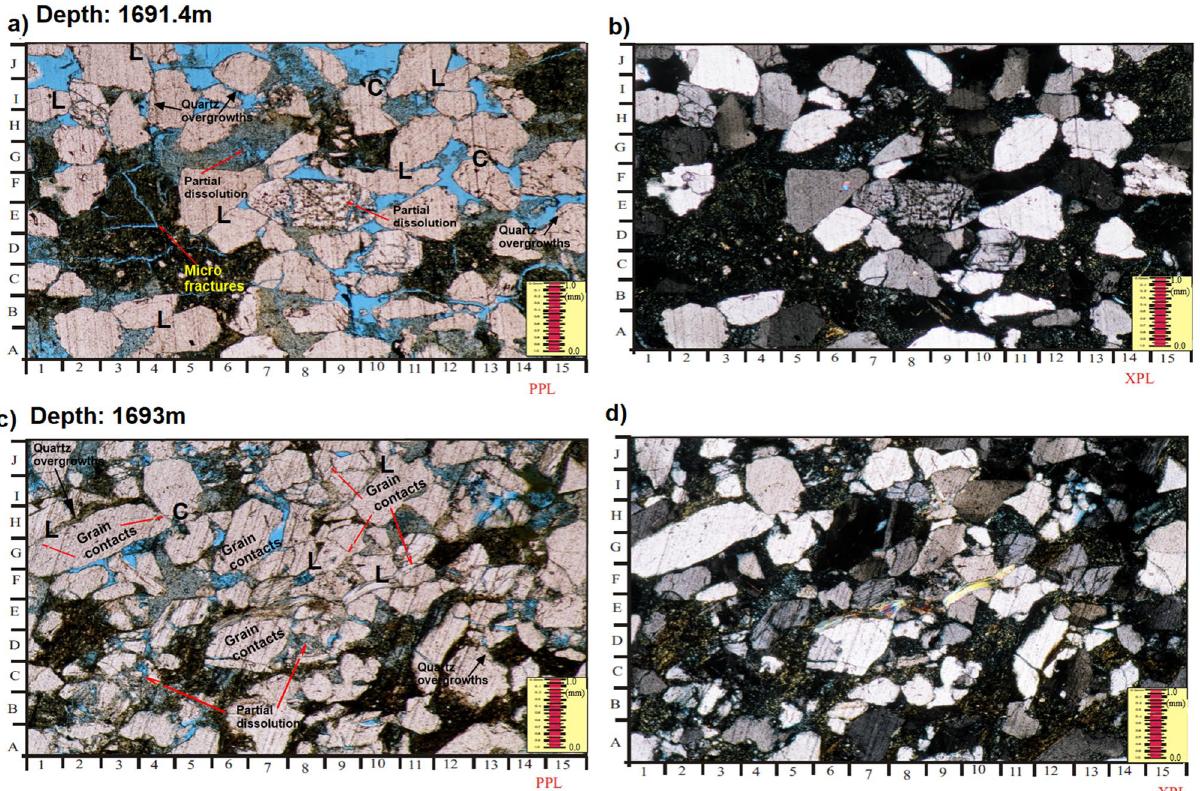
Figure 13. Thin section photomicrographs of medium grained (average mL-mU) sandstone sample that is well sorted, sub rounded to rounded, partially cemented with moderately to highly compacted with point, concavo- convex (photo a and b : H 5), few long (photo a and b : F-D 5–6) and fewer suture grain contacts. Mainly polycrystalline quartz (photo b : i-J 2–4 and photo d : C-E 5–7 and G-F 8–9) with more monocrystalline quartz (photo a : A 8–10; photo b : D-E 6–7; photo c : F–H 1–4 ) as well as considerable quantities of K-feldspars (photo a : E–F; photo b : 7–10; photos c and d : E–F 6–11), subordinate quantities of plagioclase (photo a : C-D 10–11). Some detrital clays occupying few pore spaces (photo a : G-H 4–7; photo c : F-G 4–5). Quartz overgrowths (photos a - d ) beside some patches of iron oxides occurred as cement. Leaching and dissolution of grain,